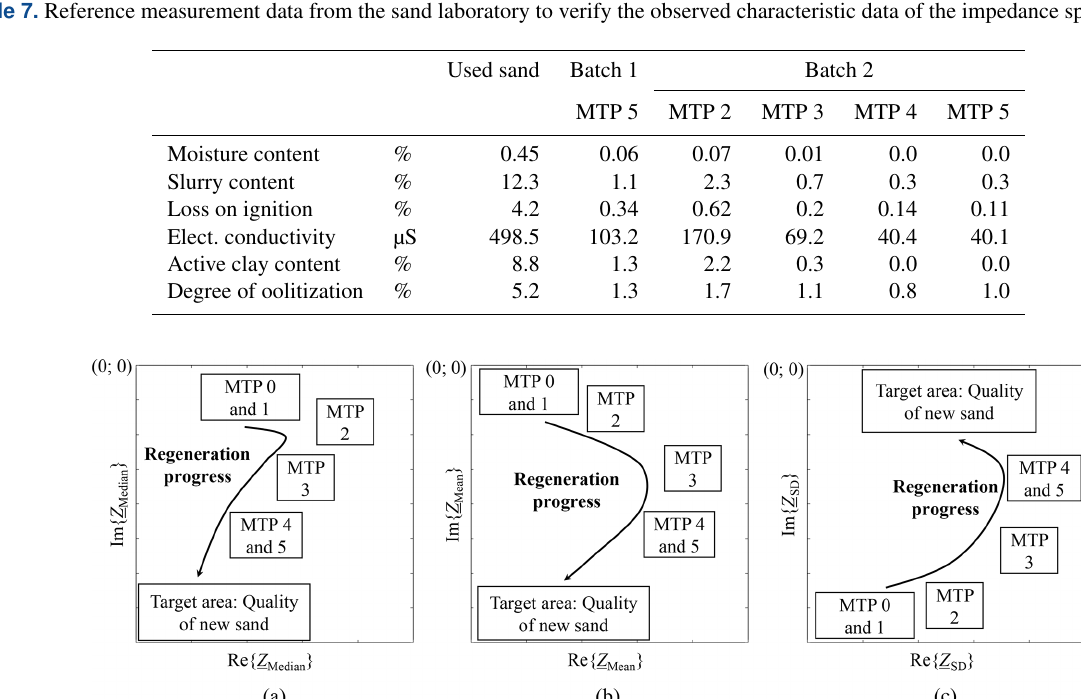
Table 7. Reference measurement data from the sand laboratory to verify the observed characteristic data of the impedance spectra.